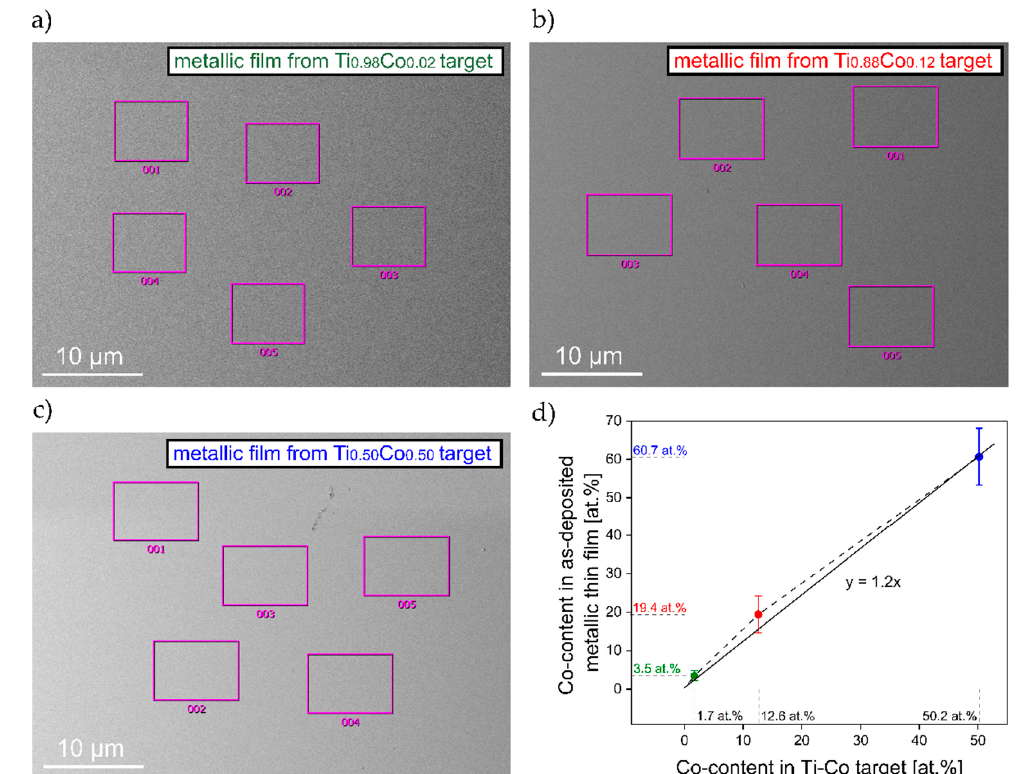
Figure 2. Images of surface topography with marked areas of EDS analysis for metallic Ti–Co thin films as deposited from: ( a ) Ti 0.98 Co 0.02 , ( b ) Ti 0.88 Co 0.12 , ( c ) Ti 0.50 Co 0.50 targets; with ( d ) a diagram of the dependence between Co-content in the target and in the metallic film.